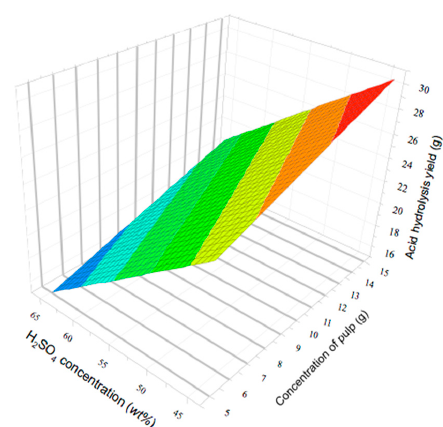
Figure 1. Response surface indicating acid hydrolysis yield as a function of sulfuric acid concentrations and initial concentration of pulp of cellulose. The other factors were kept constant: Time: 65 min; Temperature: 60 °C and time of sonication 20 min.